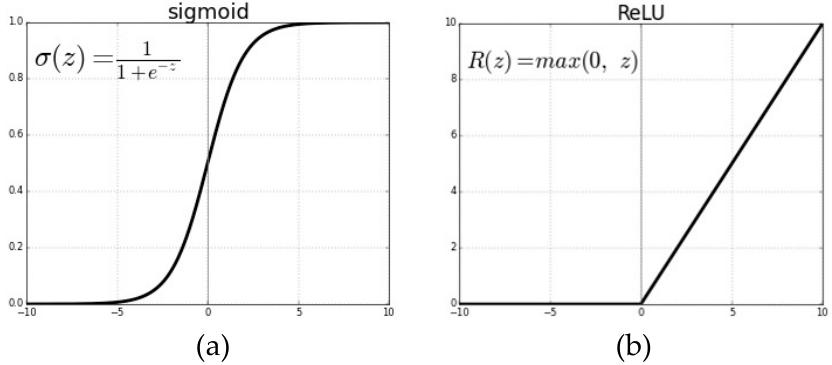
Figure 6. Comparison of two commonly used activation functions [29] : (a) Sigmoid; (b) ReLU.